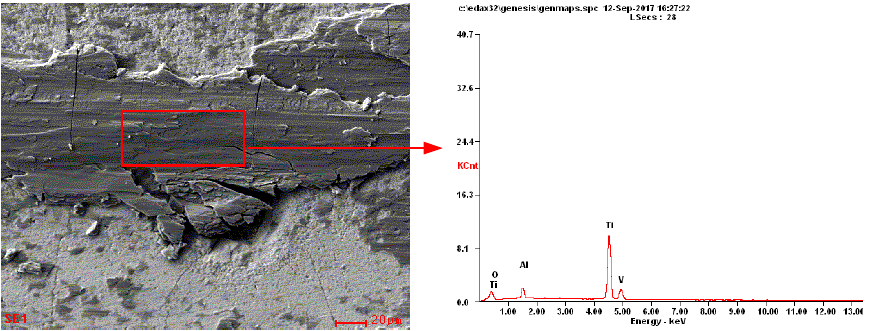
Figure 5. Energy spectrum analysis.